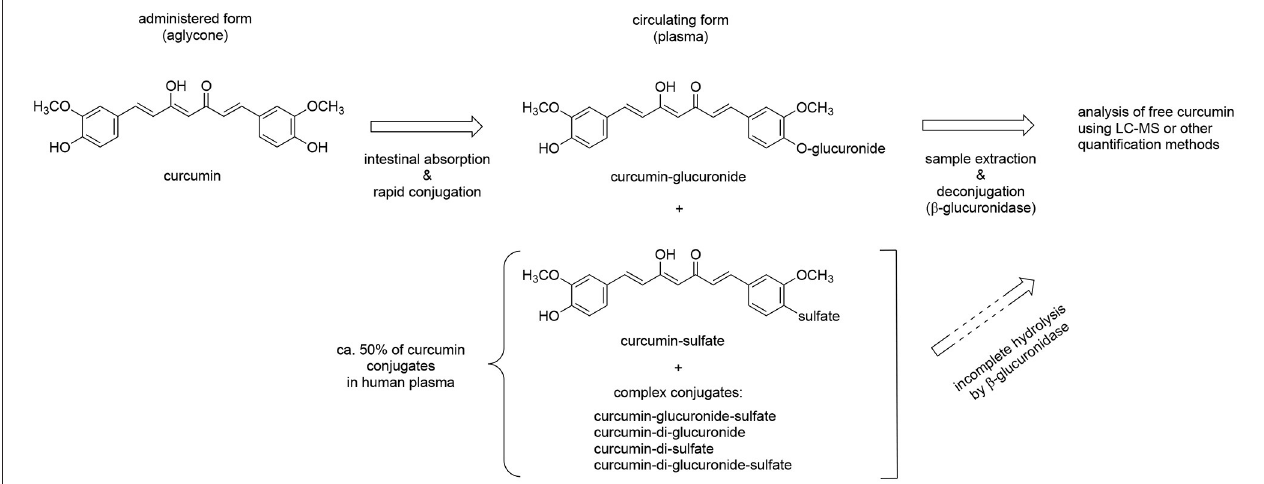
FIGURE 3 | Metabolic conjugation of curcumin and deconjugation for quantitative analysis. Curcumin is consumed in its free (aglycone) form and undergoes rapid phase II conjugation following intestinal absorption. The glucuronide conjugate accounts for about half of the circulating conjugates while sulfate and other, more complex conjugates account for the rest. Free curcumin is low or undetectable in plasma samples. For quantification plasma samples are often deconjugated using β -glucuronidase but this achieves only incomplete hydrolysis of sulfate and complex conjugates; more complete hydrolysis of all conjugates can be achieved using sulfatase. Direct analysis of conjugates is preferred but hampered by the large number of conjugates, lack of standards, and technical challenges. Reduction of the aliphatic double bonds, a significant route of metabolism in vivo , and other metabolic events are not